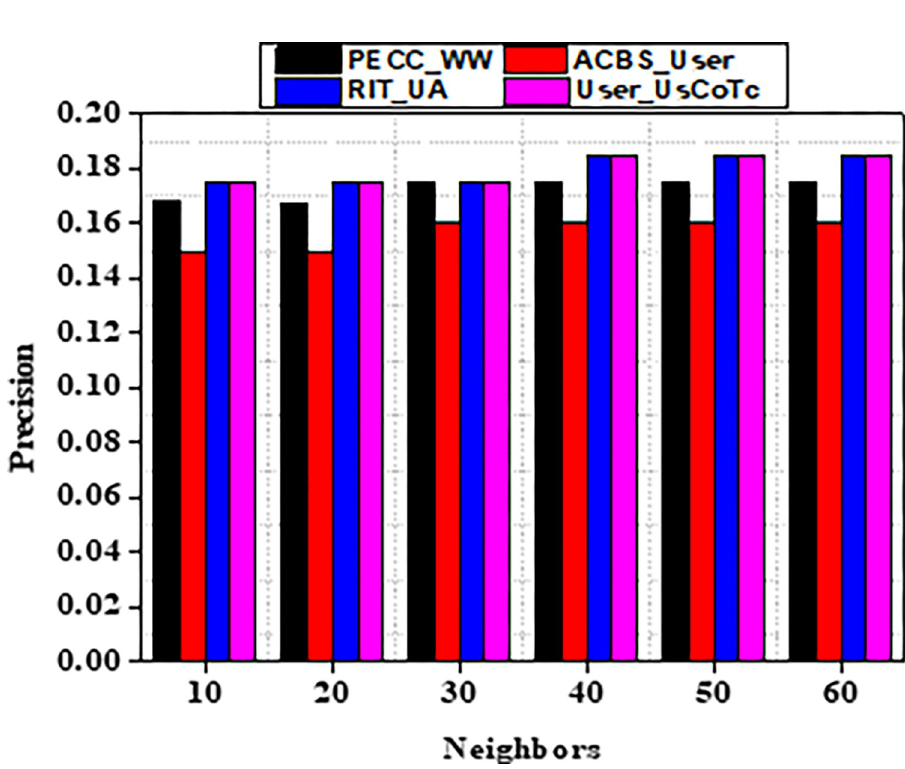
Fig 13. Precision with various neighbours.